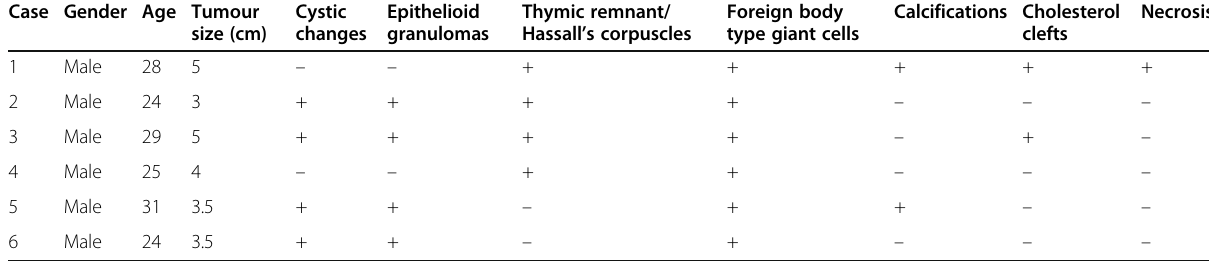
Table 1 Clinical and histological features of 6 cases described by Weissferdt et al [13] all patient had been diagnosed with an anterior mediastinal mass found to be a primary mediastinal seminoma with follicular hyperplasia on histological examination with the same immunohistology stains as in our